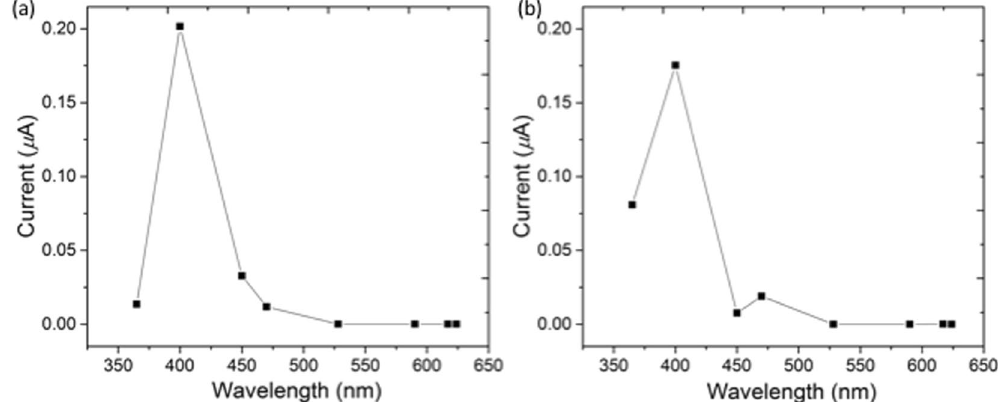
Figure 5. ( a ) Photocurrent at 4 V of the xerogel of 1 + 3 at different wavelengths; ( b ) Photocurrent at 4 V of the xerogel of 2 + 3 at different